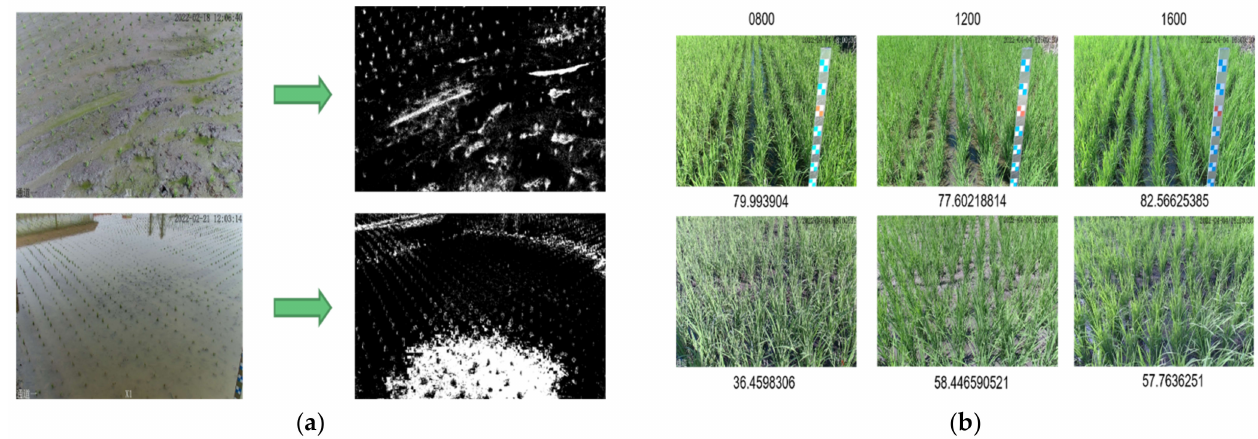
Figure 13. GC Workflow and GC at Different Capturing Angles. ( a ) The workflow of the GC Procedure and the Output Results. ( b ) Different Results from Different Capturing Angles.